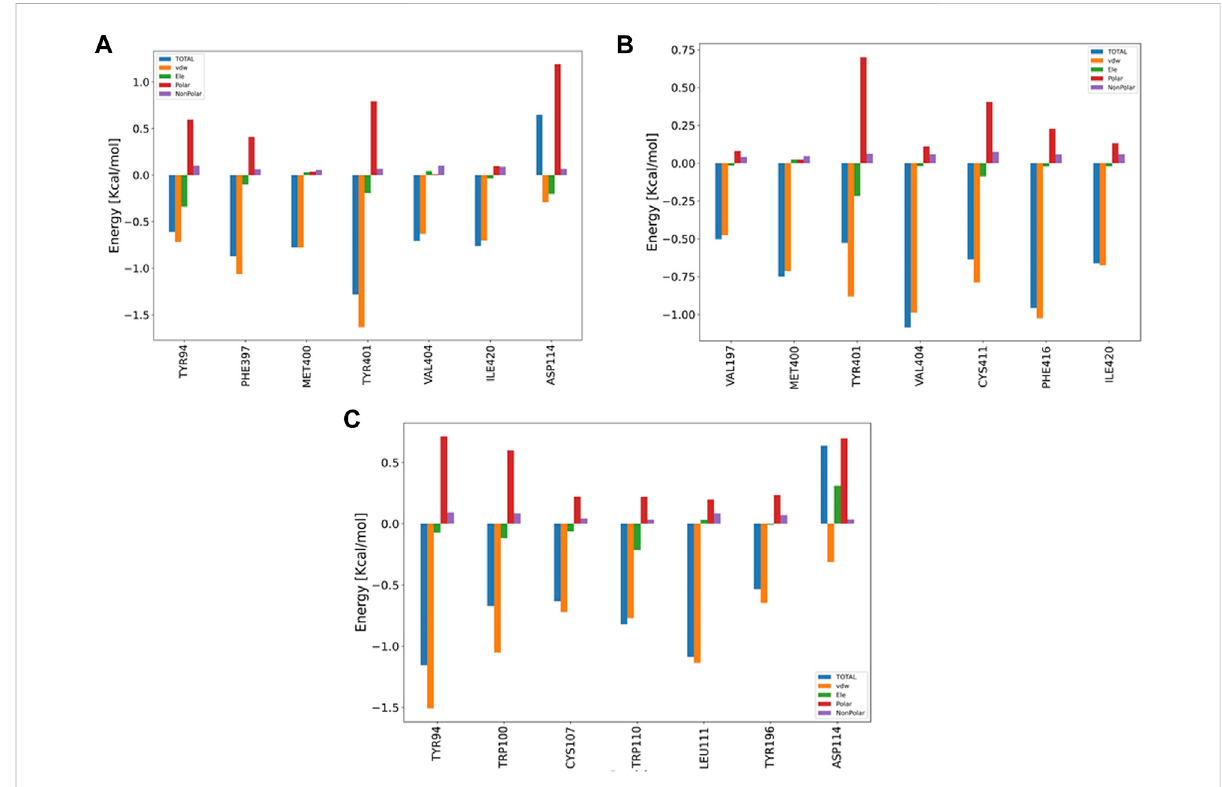
FIGURE 9 Bar plot depiction of energy decomposition as the VDW, electrostatic, polar solvation, and total energies for B12, B23, and